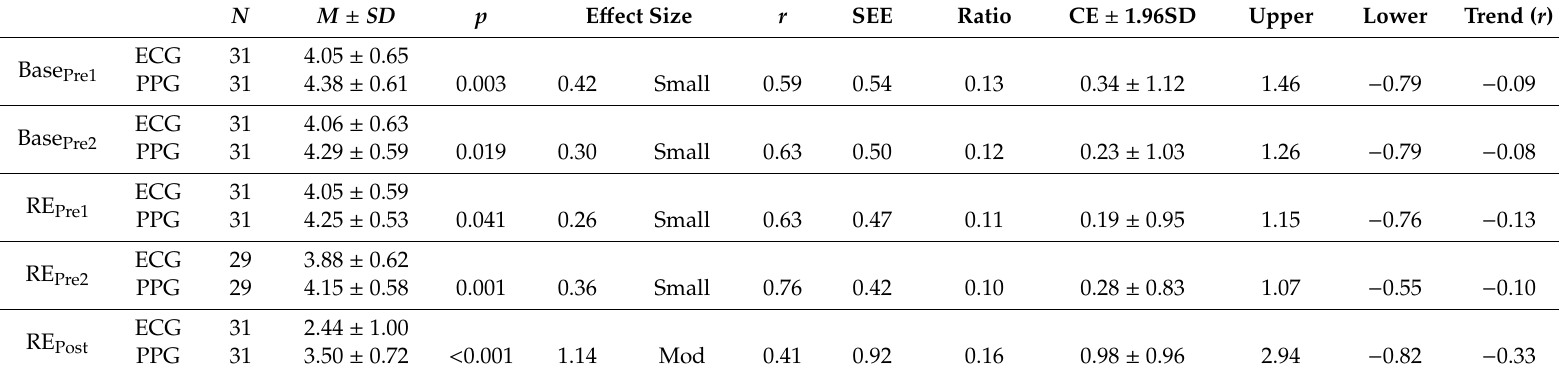
Table 1. Comparison of electrocardiograph (ECG) and photoplethysmography (PPG)-derived log transformation of the root mean square of successive RR di ff erences